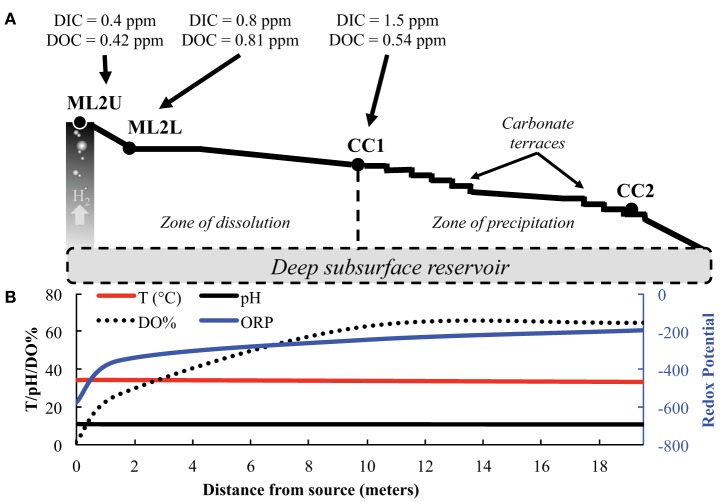
Manleluag source and outflow channel site sampling regime. (A) Samples were collected from Manleluag Seep 2 Upper (ML2U), Lower (ML2L), and Caustic Cascade 1 (CC1). H2 degasses from the serpentinizing fluid as it approaches ML2U. Carbon dioxide in the atmosphere dissolves as inorganic carbon (DIC) along the outflow channel. Leaf litter and insects, etc… contribute to dissolved organic carbon (DOC) along the outflow channel. Scale bar denotes distance from source in meters. (B) Selected geochemical data from Manleluag; temperature, pH, and DO% are presented on the primary y-axis, ORP (oxidative-reductive potential) on the secondary y-axis, and distance from the source, in meters, on the x-axis. Please see Cardace et al. (2015), for a detailed analysis of geochemical parameters.